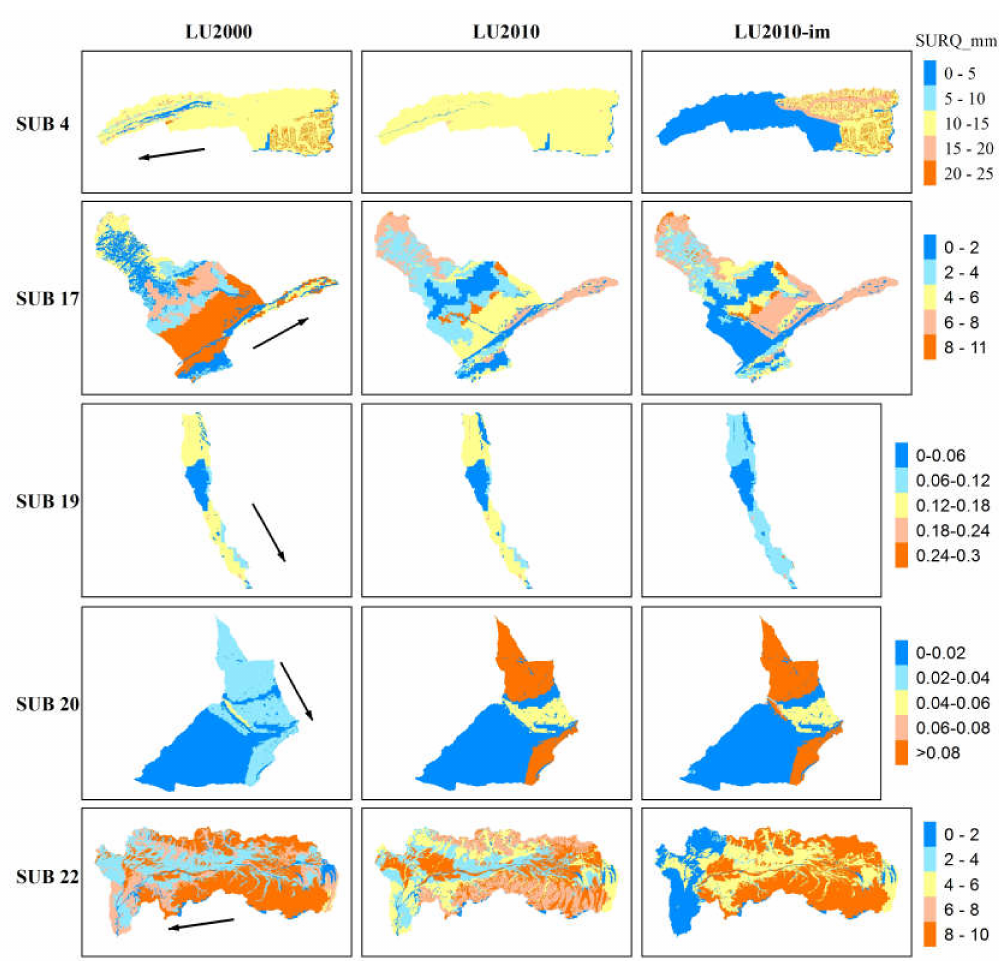
Figure 8. Spatial distribution of surface runoff (mm/month) at the HRU level (mean 2002–2007) for the LU2000, LU2010, and U2010-im models in sub-basins. The arrow indicates the flow